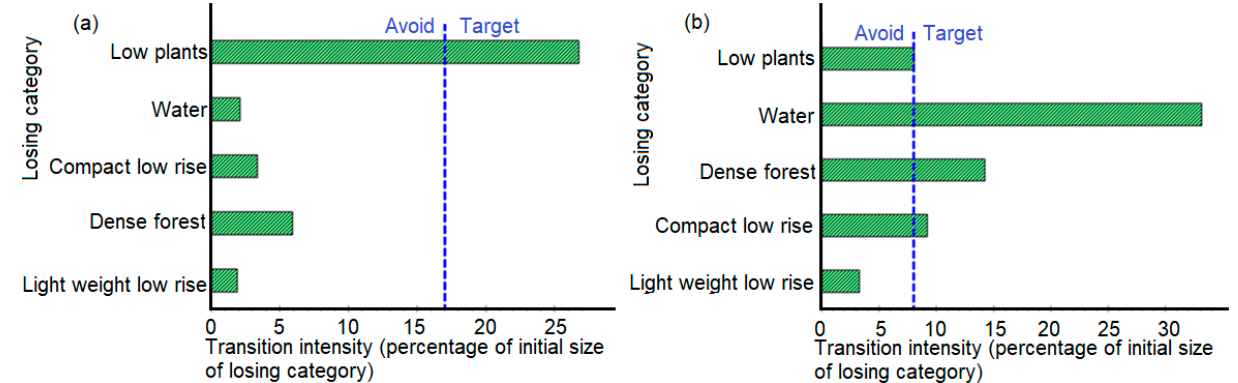
Figure 8. Transition intensity given gain of Open low rise from ( a ) 1990 to 2005 and ( b ) 2005 to 2020.